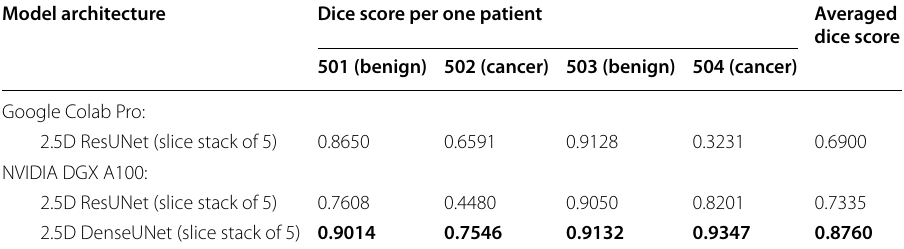
The best result regarding each Thai patient is highlighted in bold